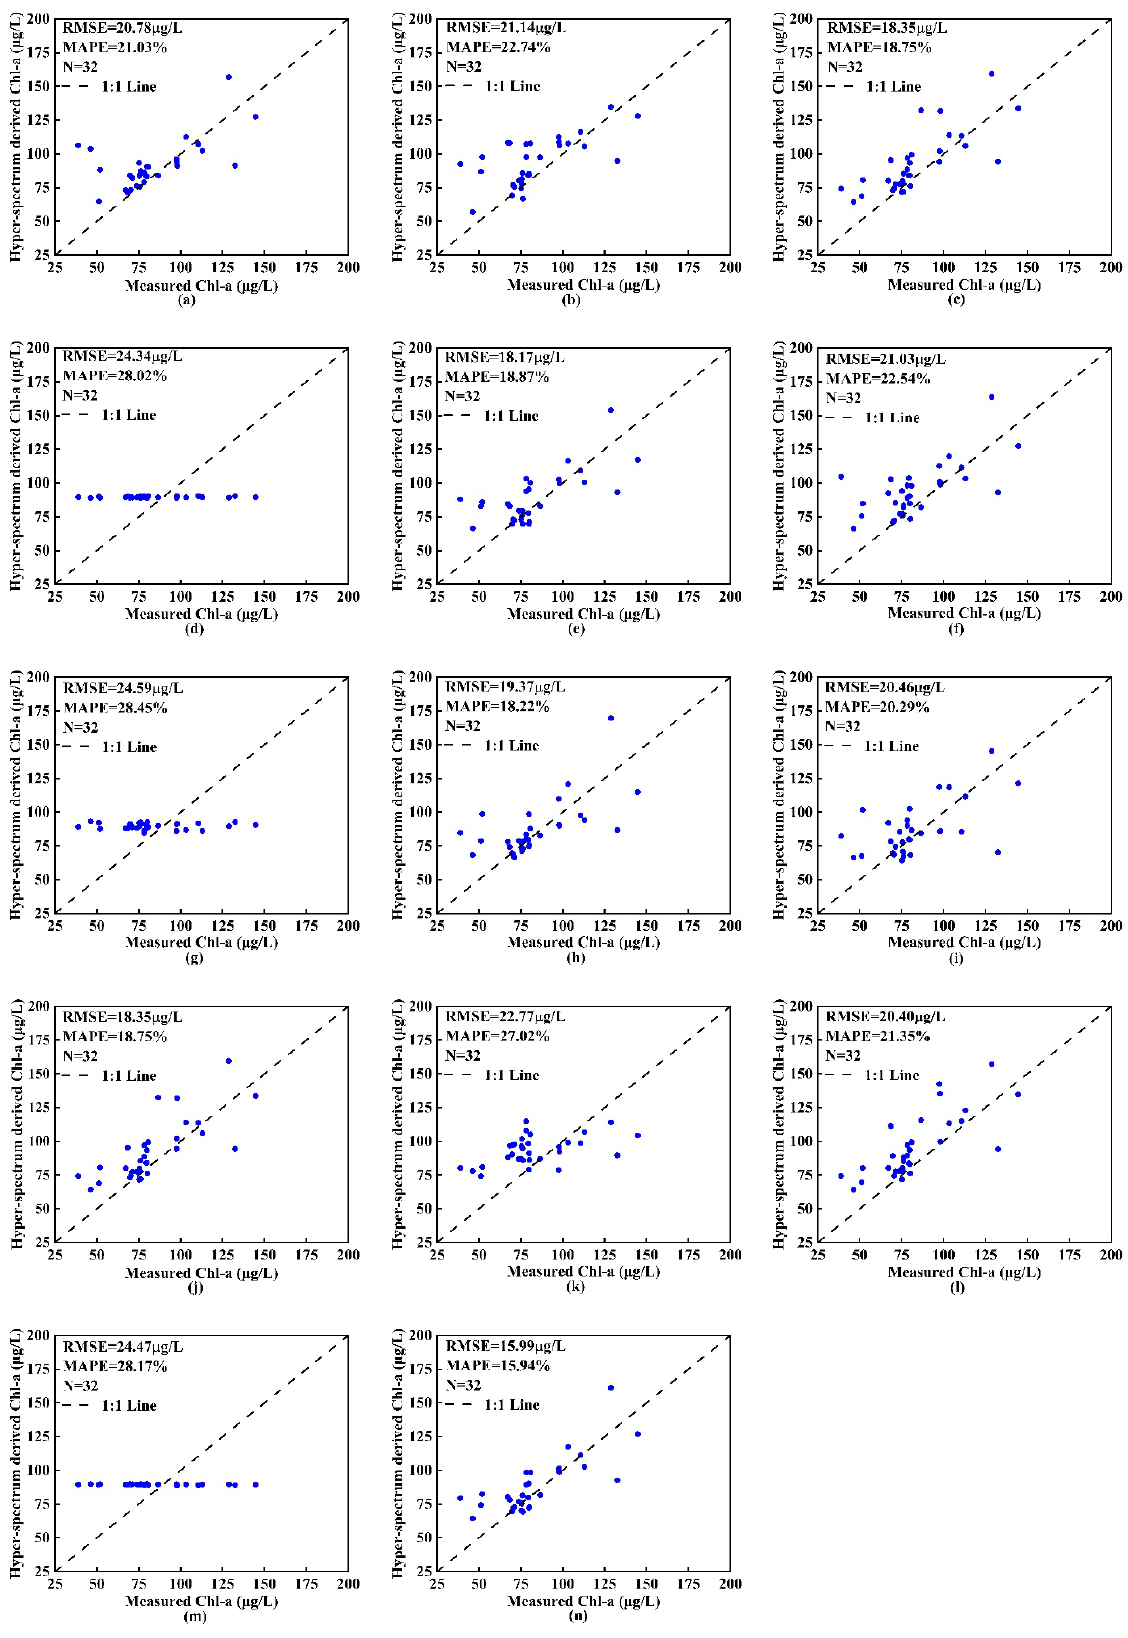
Figure A2. Comparison of the validation results of existing Chl-a concentration retrieval algorithms based on measured data. ( a – n ) are the validation of the reconstruction models in Figure A1 in turn.